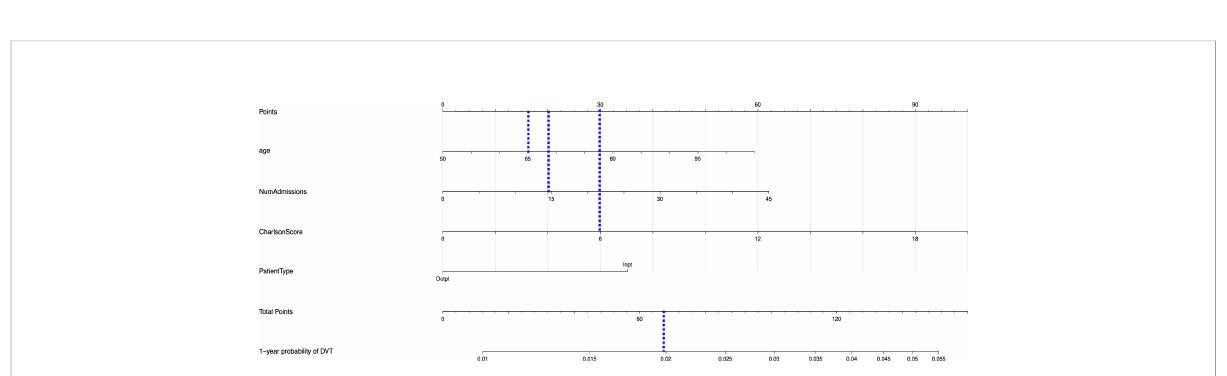
FIGURE 4 Nomogram for predicting the 1-year probability of DVT in patients with GCA. NumAdmissions, number of admissions; Outpt, outpatient; Inpt,